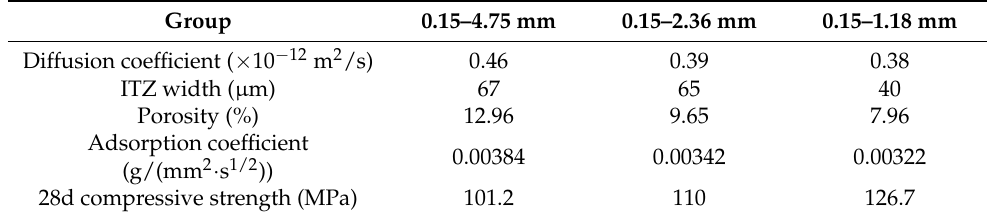
Table 9. Relevant parameters of L-UHPC under different LWA particle